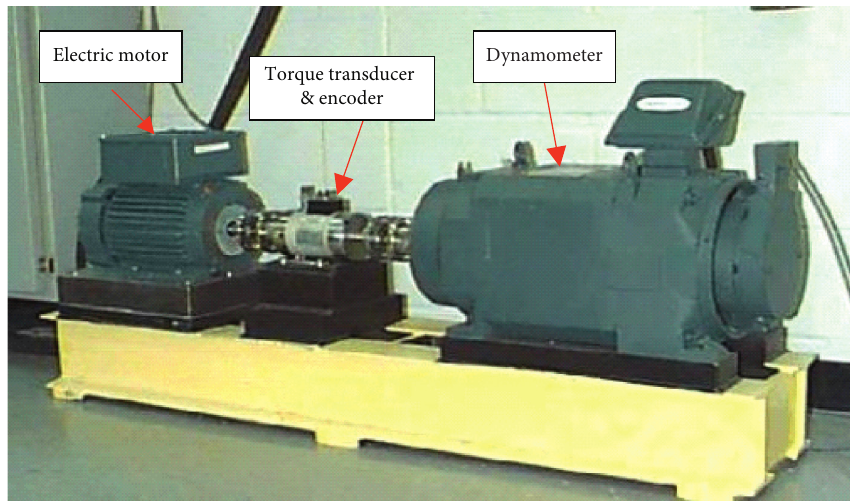
Figure 20: CWRU bearing failure test device. Table 5: Geometry and characteristic frequencies of the rolling bearing.